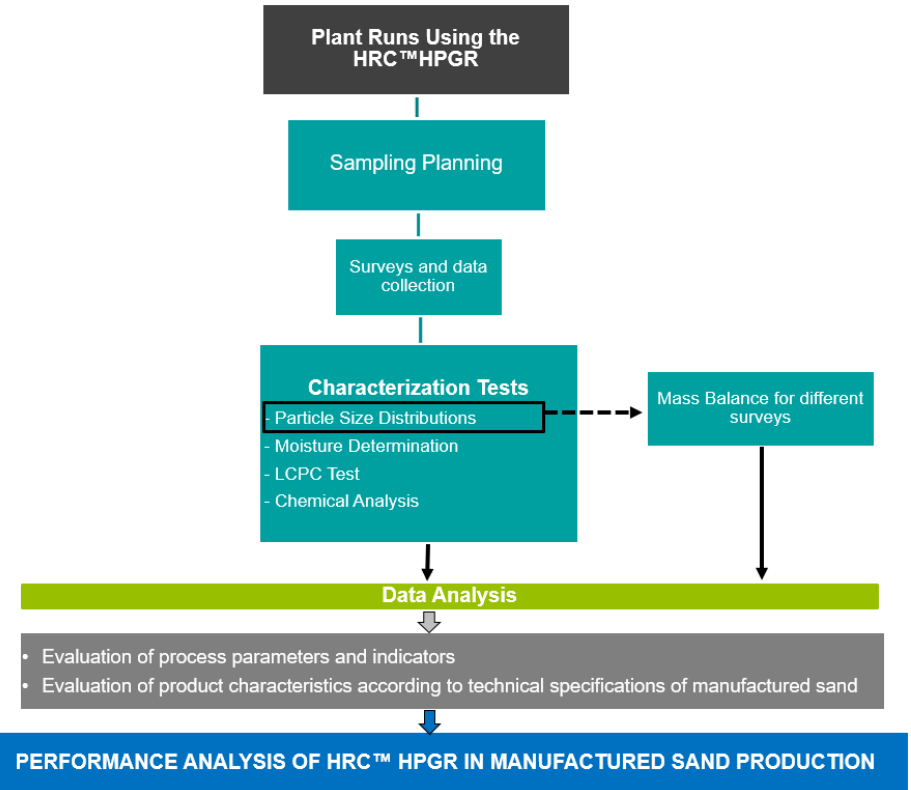
Figure 4. Method adopted for assessing the performance of HRC™ in the Itaquareia industrial processing plant.